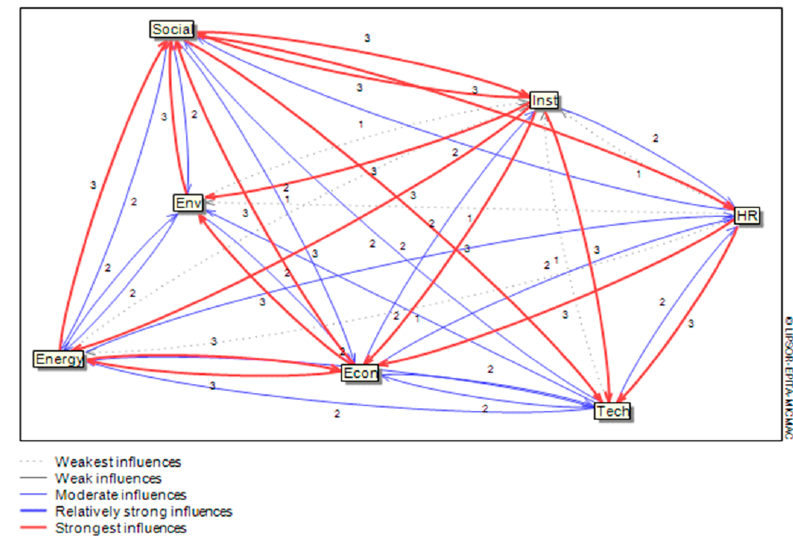
Figure 3. Value-directed network showing how all seven categories of capacity interact. This graph was created using the MICMAC software developed by Godet (1986). Inst.: institutional; HR: human resources; Tech.: Technical; Econ.: Economic/Financial; Env.: Environmental.